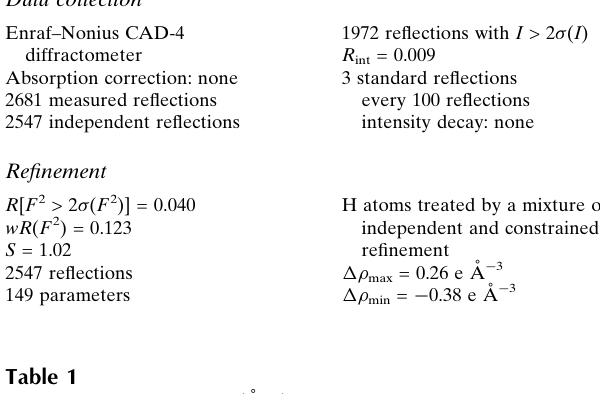
Hydrogen-bond geometry (A˚ , (cid:2)